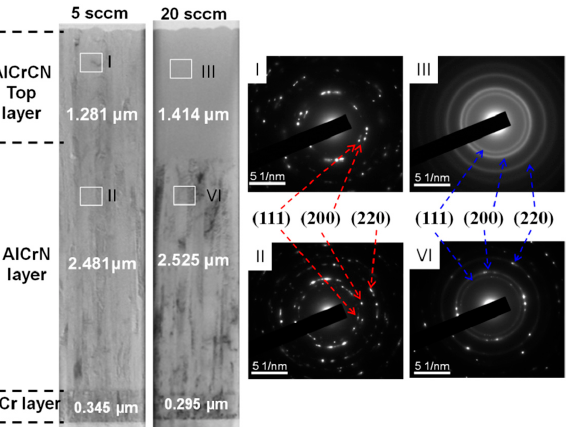
Figure 3. TEM image and SAED patterns of AlCrCN coatings as a function of C 2 H 2 flow (5 and 20 sccm).